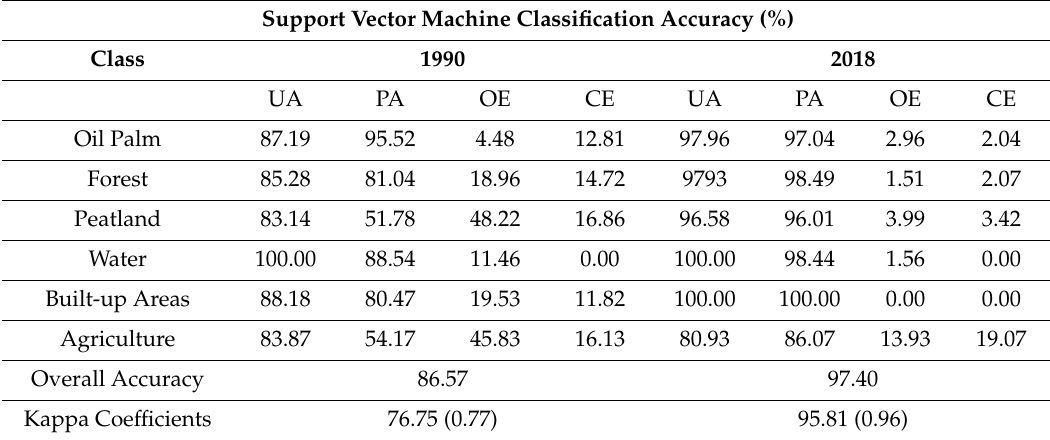
Table 4. Sabah land-use classification accuracy assessment.